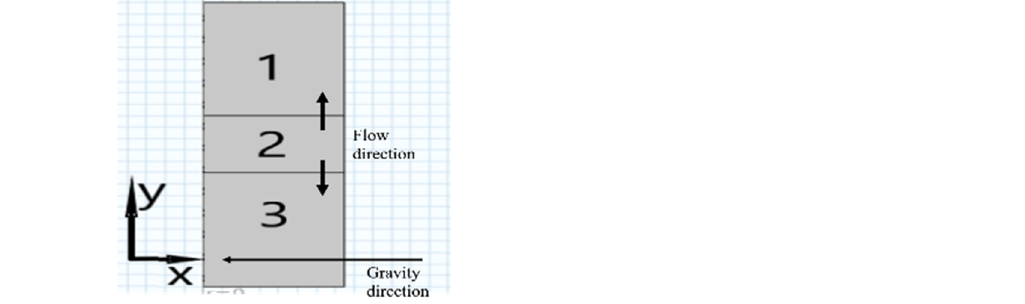
Figure 3. GDL aperture transmission simplified model. 1, 2, and 3, respectively, are for each phase region, and the intake direction is in the negative Y direction.